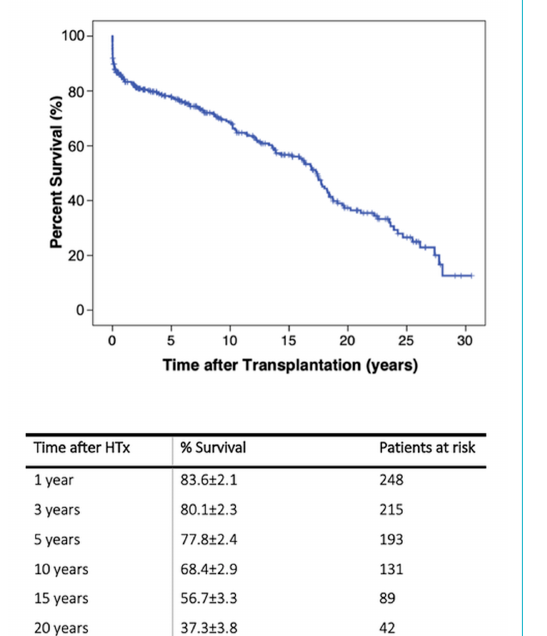
Figure 1: Kaplan-Meier estimate of overall survival after heart transplantation in the years 1987–2018.